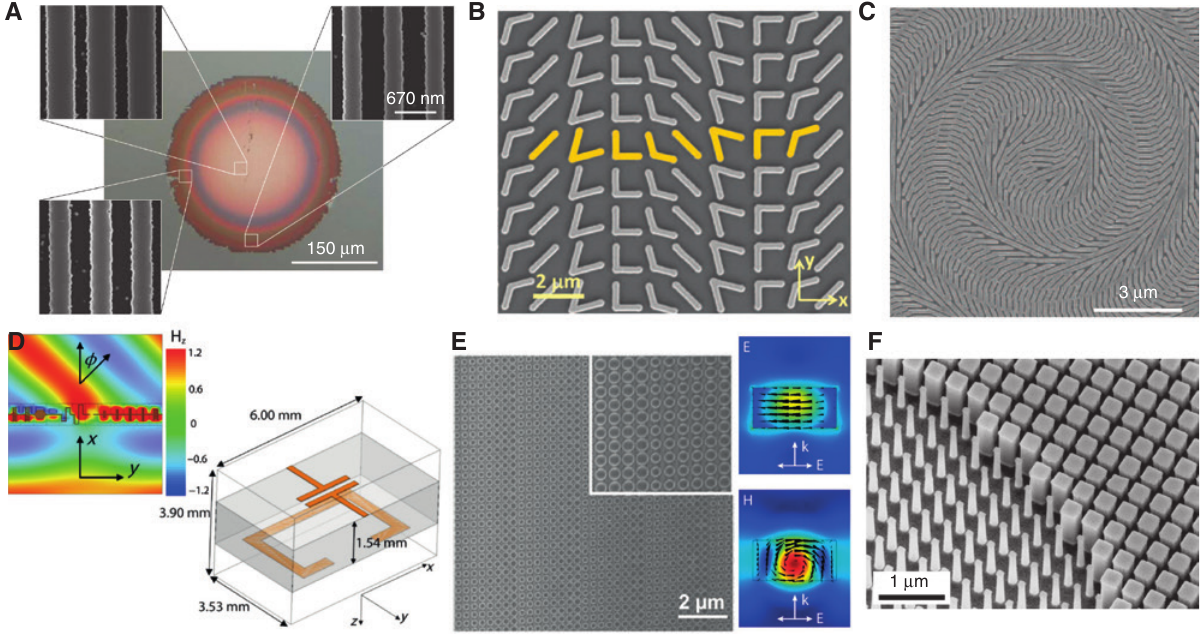
Figure 1: Recent advances in metasurfaces. (A) Optical and scanning electron micrographs of a high-contrast grating mirror with focusing ability [32]. (B) Scanning electron micrograph of a plasmonic metasurface beam deflector [17]. (C) A geometric phase axicon with dielectric microbars [39]. (D) Microwave beam deflec- tion with a metallic Huygens’ metasurface along with unit cell of the beam deflector [40]. (E) Scanning electron micrograph of a dielectric Huygens’ beam deflector. Simulated field intensities are plotted on the right [41]. (F) Scanning electron micrograph of a portion of a high- contrast transmitarray lens